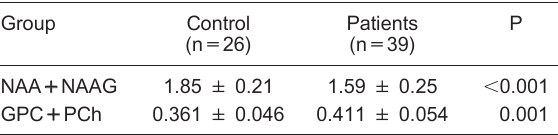
Table 3. Metabolite concentrations relative to the Cr++PCr concentration for the original groups (26 control subjects and 39 Huntington’s disease